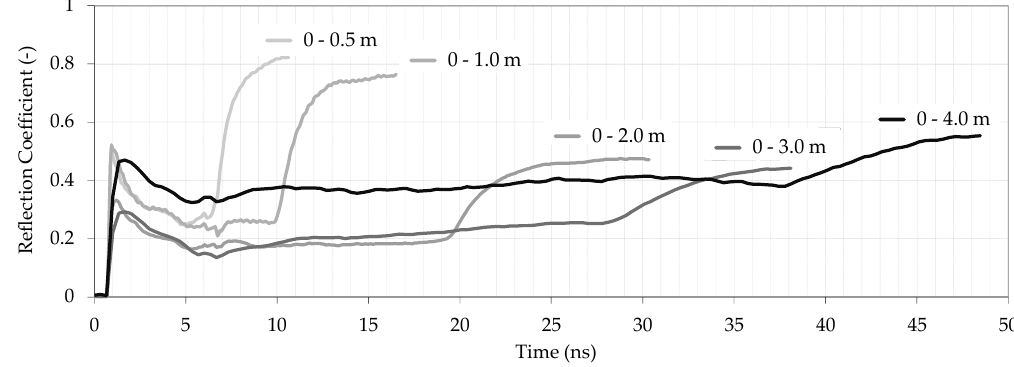
Figure 13. Grugliasco site, 20 May 2010. Waveforms detected with different TDR waveguides lengths vertically inserted into the soil from the surface down to 4 m depth.